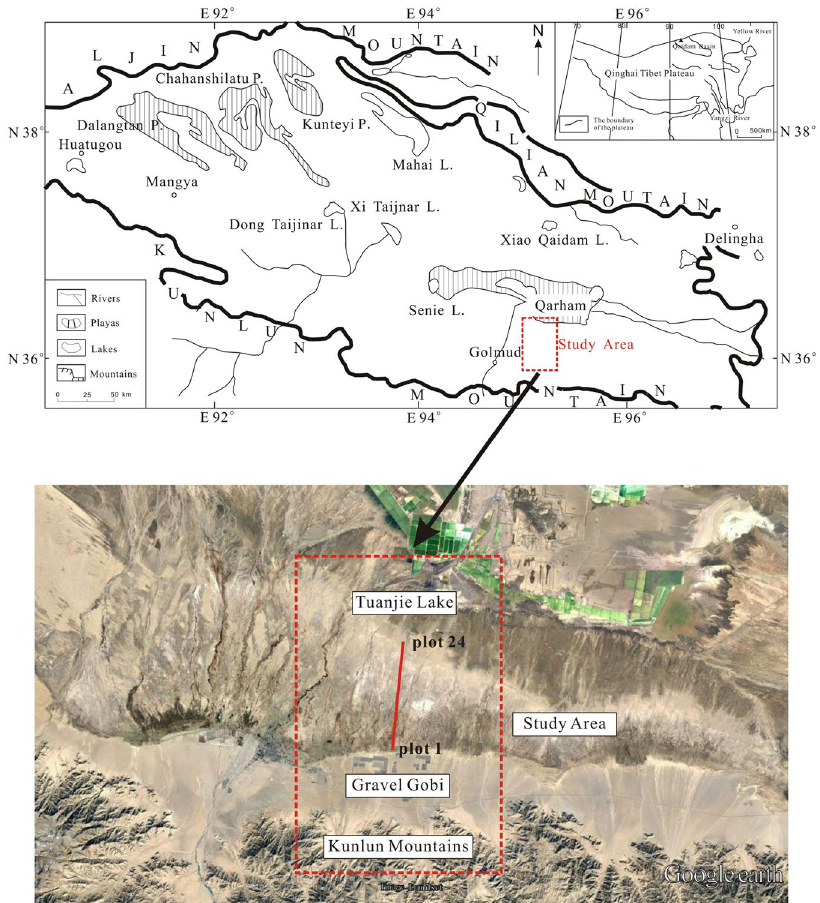
Figure 1. The distribution of saline lakes in the Qaidam Basin and the location map of the study site. Plots 1 to 24 are distributed from a gravel Gobi area to Tuanjie Lake. The upper part of the Fig. 1 was drawn by Xianjie Wang using Corel DRAW software (Corel DRAW X4 14.0.0.701), and the lower part was modified from map downloaded from Google Earth on May 2017 (Google Earth